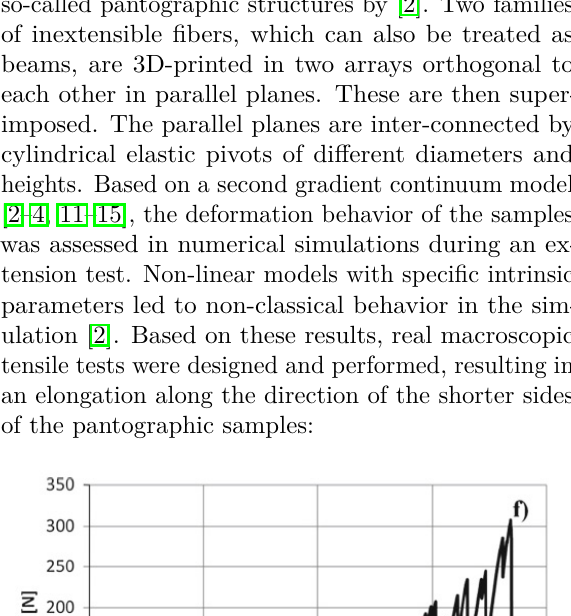
Table 1. Overview of five specimens with different beam and pivot parameters.